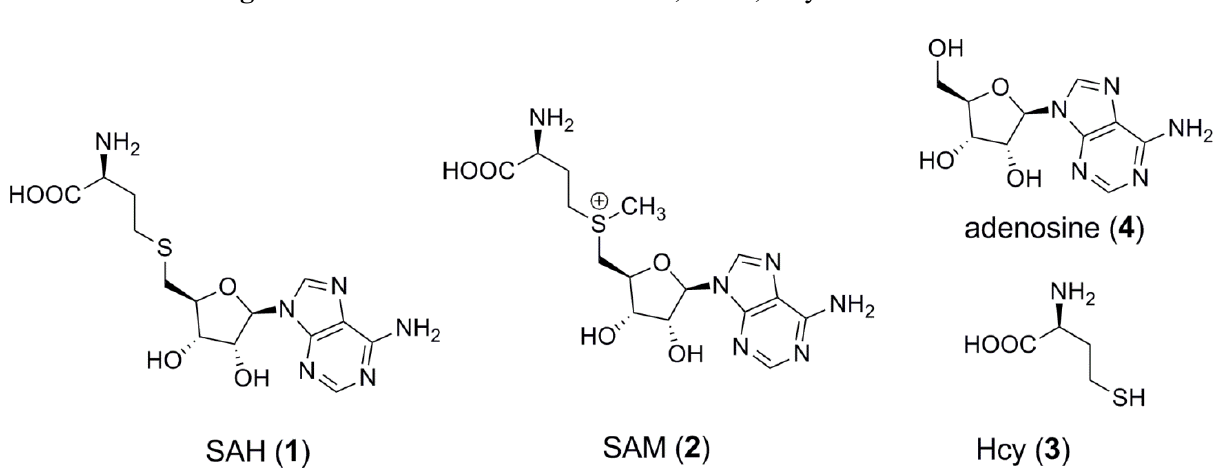
Figure 1. Chemical structures of SAH, SAM, Hcy and